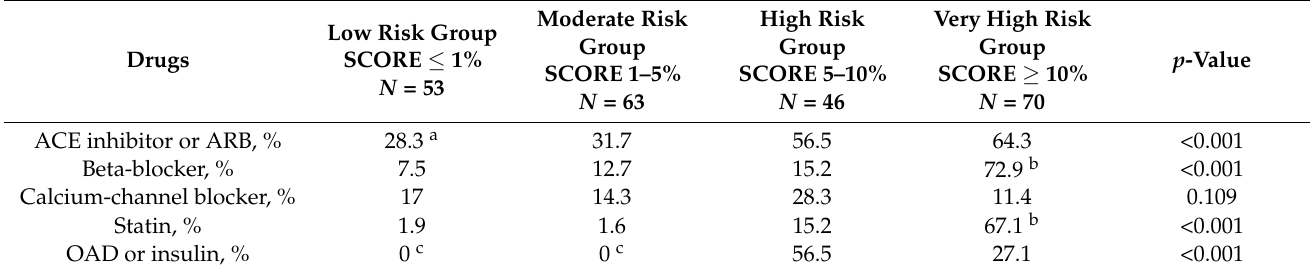
Table 3. Comparisons of Medical Therapy Between SCORE Risk Groups.